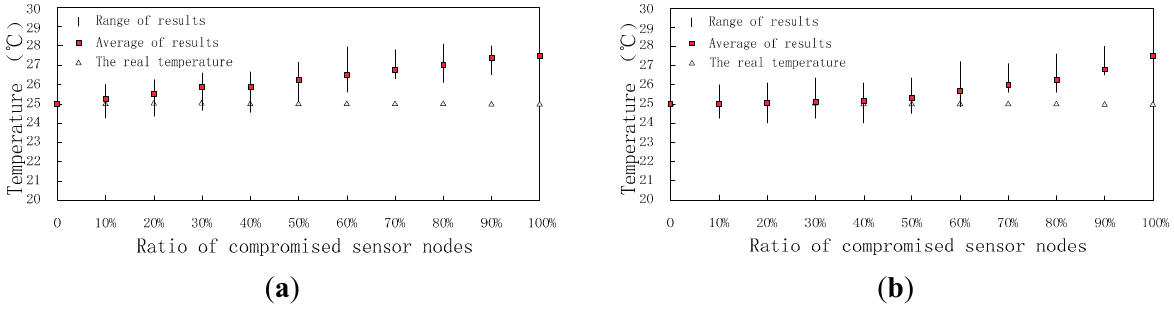
Figure 14. Data fusion results of temperature versus ratio; ( a ) without DCHM and ( b ) using DCHM.